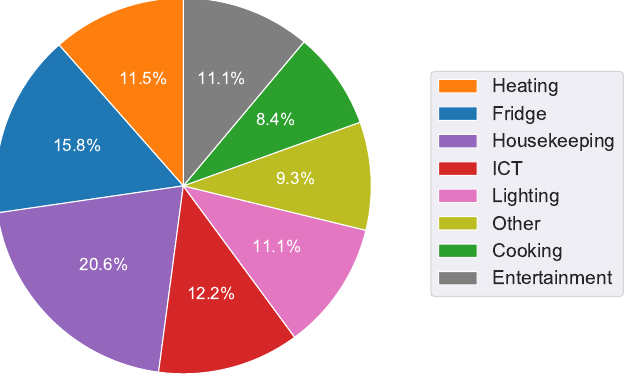
Figure 7. Breakdown of electrical energy consumption in Germany’s private households 2006